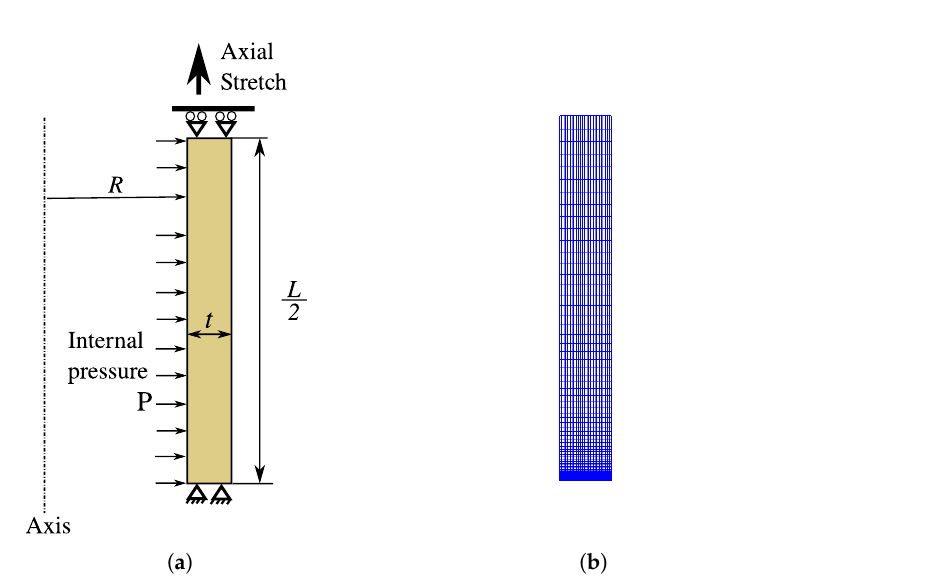
Figure 6. ( a ) 2D representation of the boundary conditions for the simulation of the pressurization test. ( b ) Structured mesh of the finite element simulation with 2500 quadrilateral